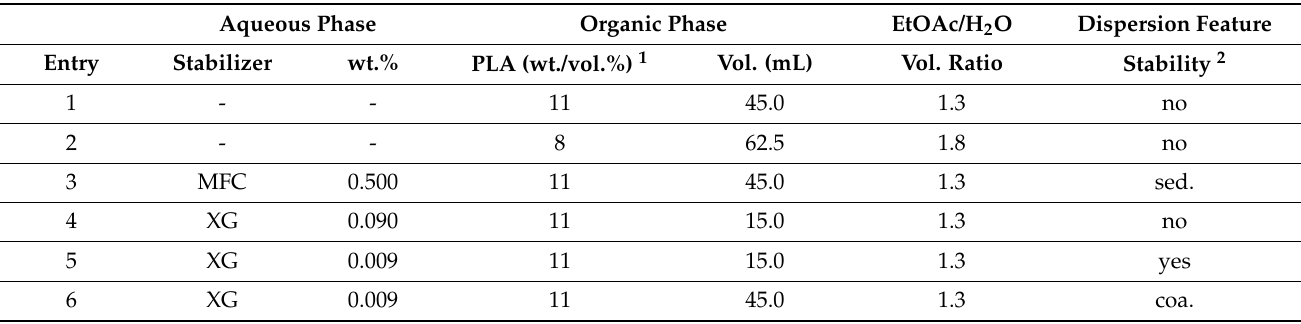
Table 2. Screening of different stabilizers for the preparation of PLA dispersions in the presence of SDS as surfactant.